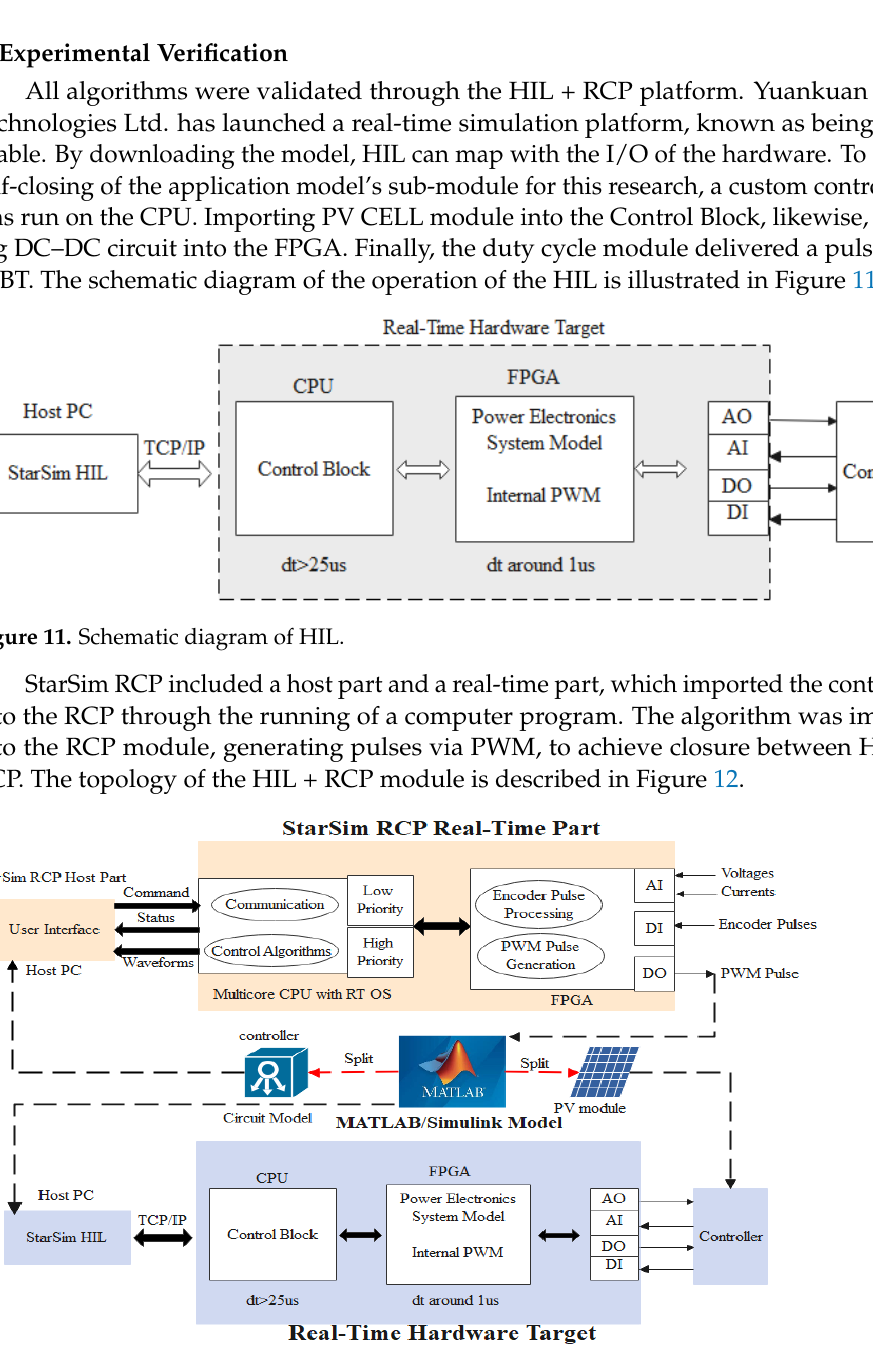
Figure 12. Schematic diagram of HIL+RCP.